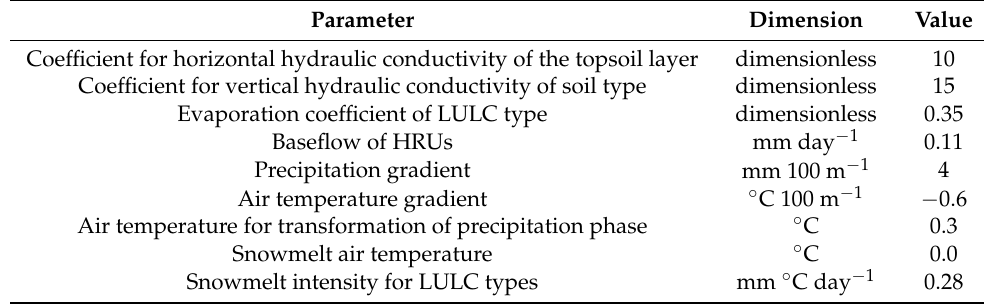
Table 4. Calibration parameters of the ECOMAG model for the Iya River